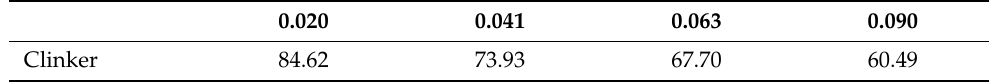
Table 17. Laser granulometry analysis of clinker, over sieve